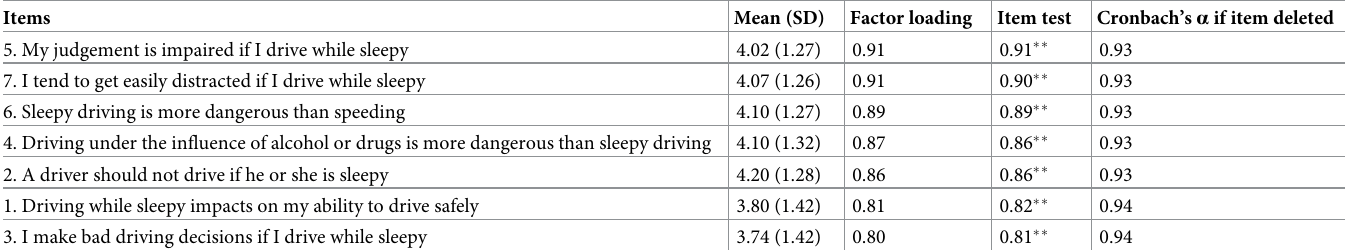
Table 2. The factor loadings and item